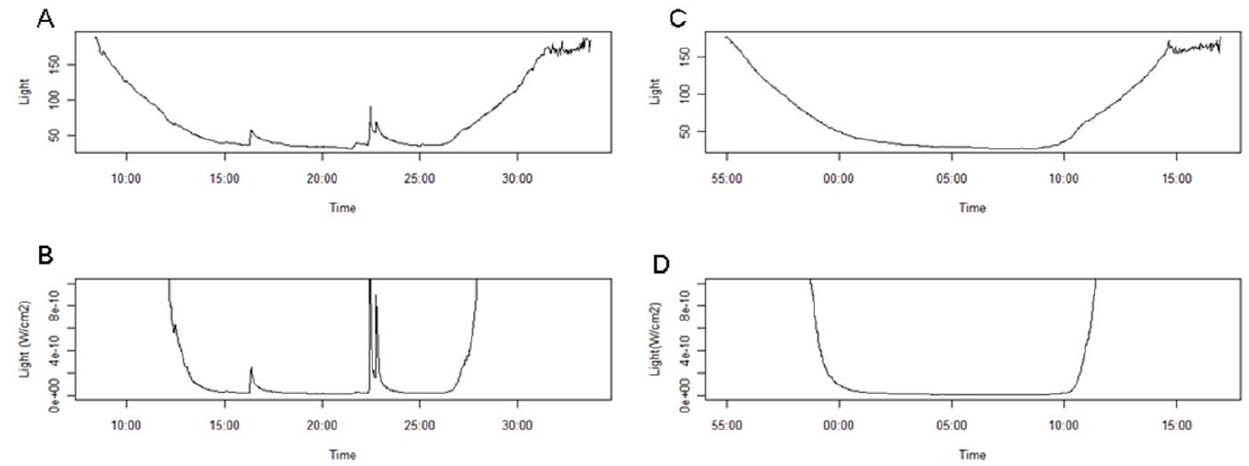
Figure 7. Bioluminescence and foraging intensity. A–B. A light profile (raw values=A; W/cm 2 =B) for a dive with many bioluminescence events and a high foraging index, controlling for depth and bottom time. C–D. A light profile (raw values=C; W/cm 2 =D) for a dive without bioluminescence events and a low foraging index, controlling for depth and bottom time.